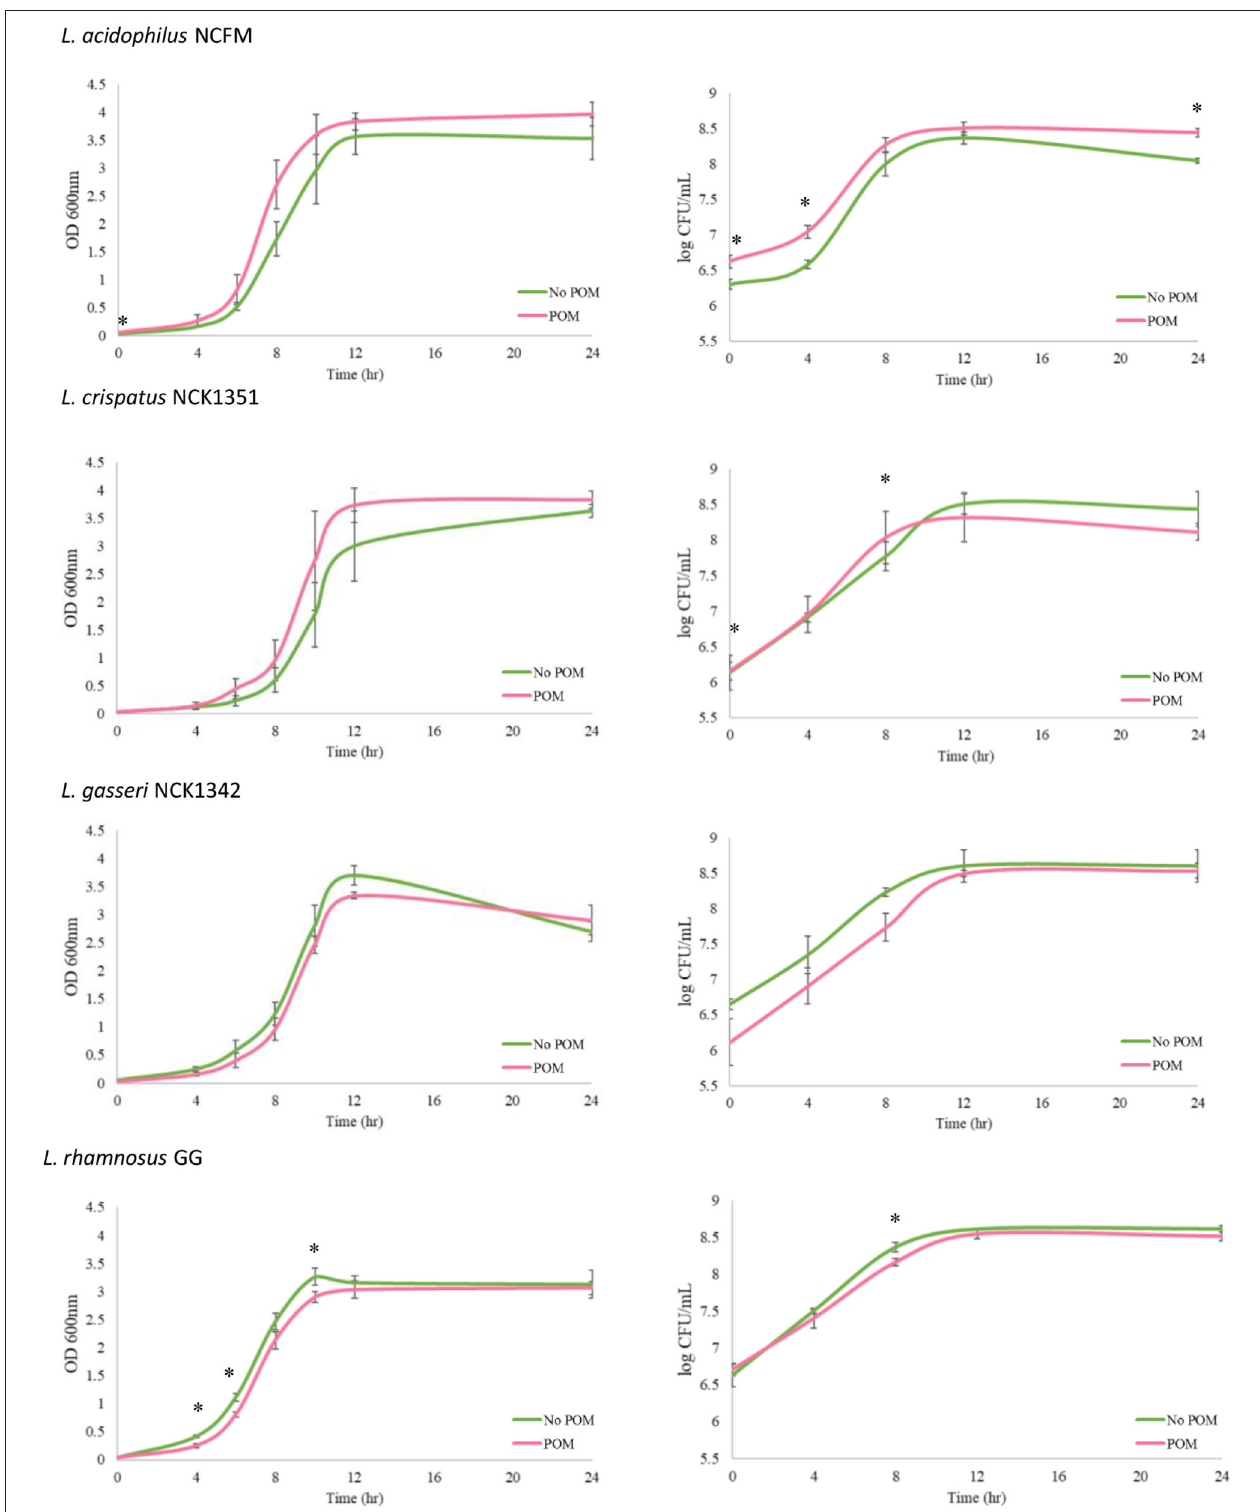
FIGURE 1 | Growth of Lactobacillus strains with and without the POM extract (400 µ g/ml). Growth assays were performed over a 24-h period with the L. acidophilus NCFM, L. crispatus NCK1351 , L. gasseri NCK1342, and L. rhamnosus GG grown in SDM with 0.5% glucose and no POM extract (green curve, No POM) or in SDM with 0.5% glucose and 400 µ g/ml of POM extract (red curve, POM). Graphs on the left-hand side show OD 600nm values, and log CFU/ml growth curves are shown on the right-hand side. Error bars represent the standard deviation of three biological replicates, and * indicates p ≤ 0.05.